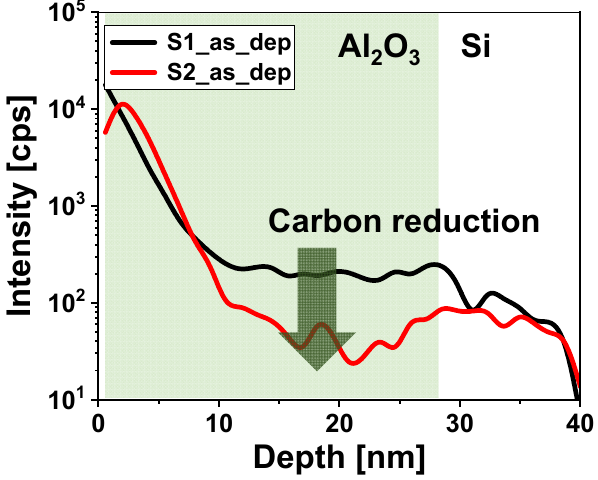
Figure 5. Secondary ion mass spectrometry (SIMS) depth profiles of carbon in the Al/Al 2 O 3 /Si gate stack with an O 2 plasma exposure time of 3 (black line) and 7 s (red line).